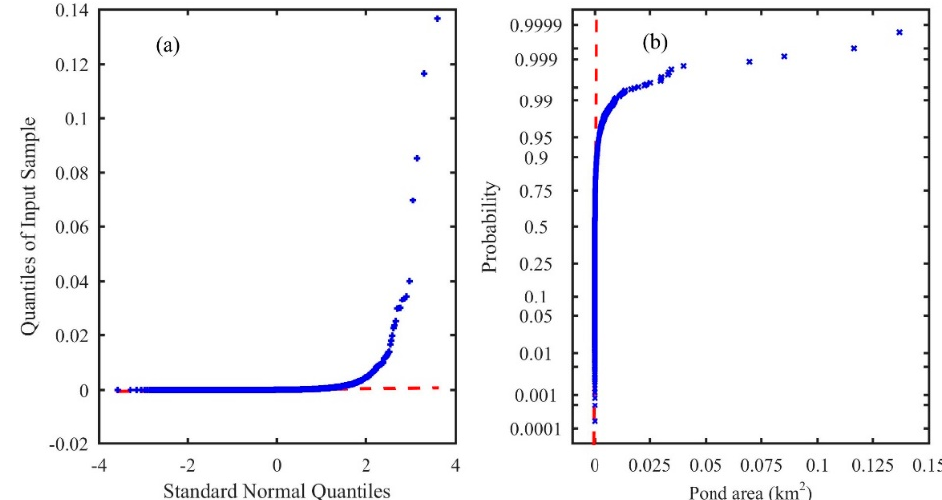
Figure 3. Distribution of ponded areas (1989–2017) in the Everest region using (a) normal Q-Q plot, and (b) normal probability plot.